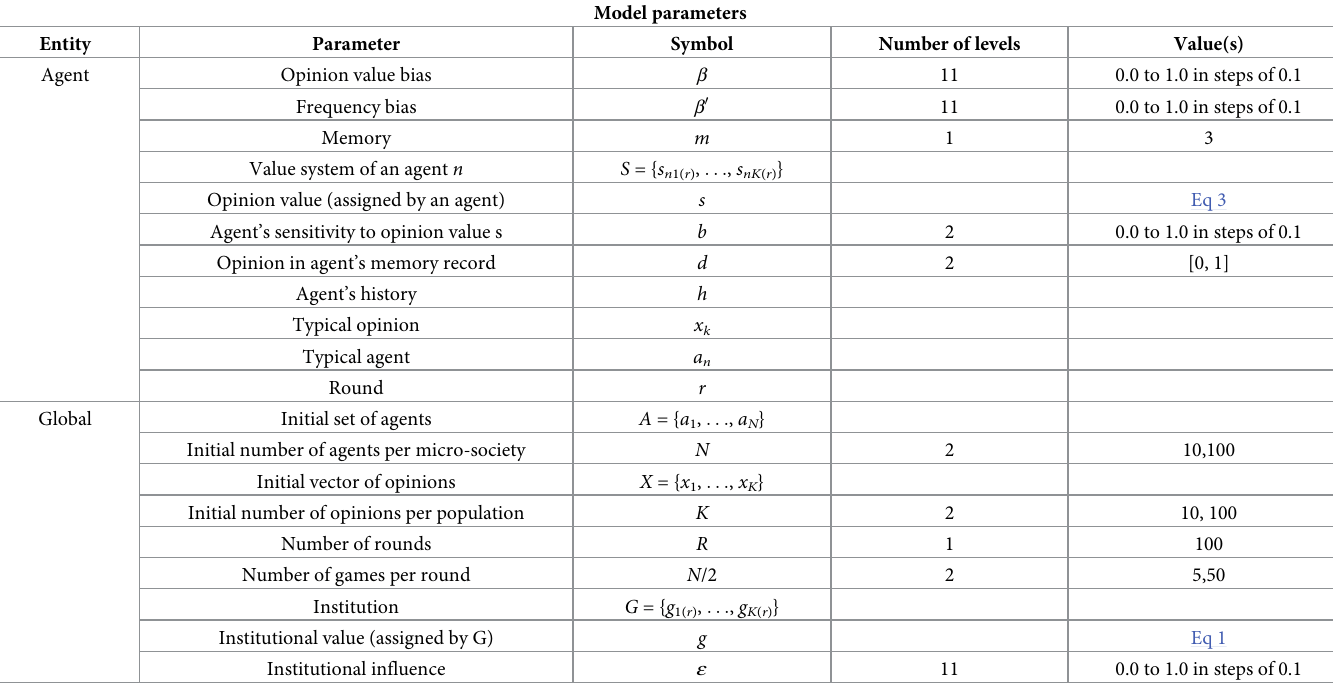
Table 1. Parameters, state variables and